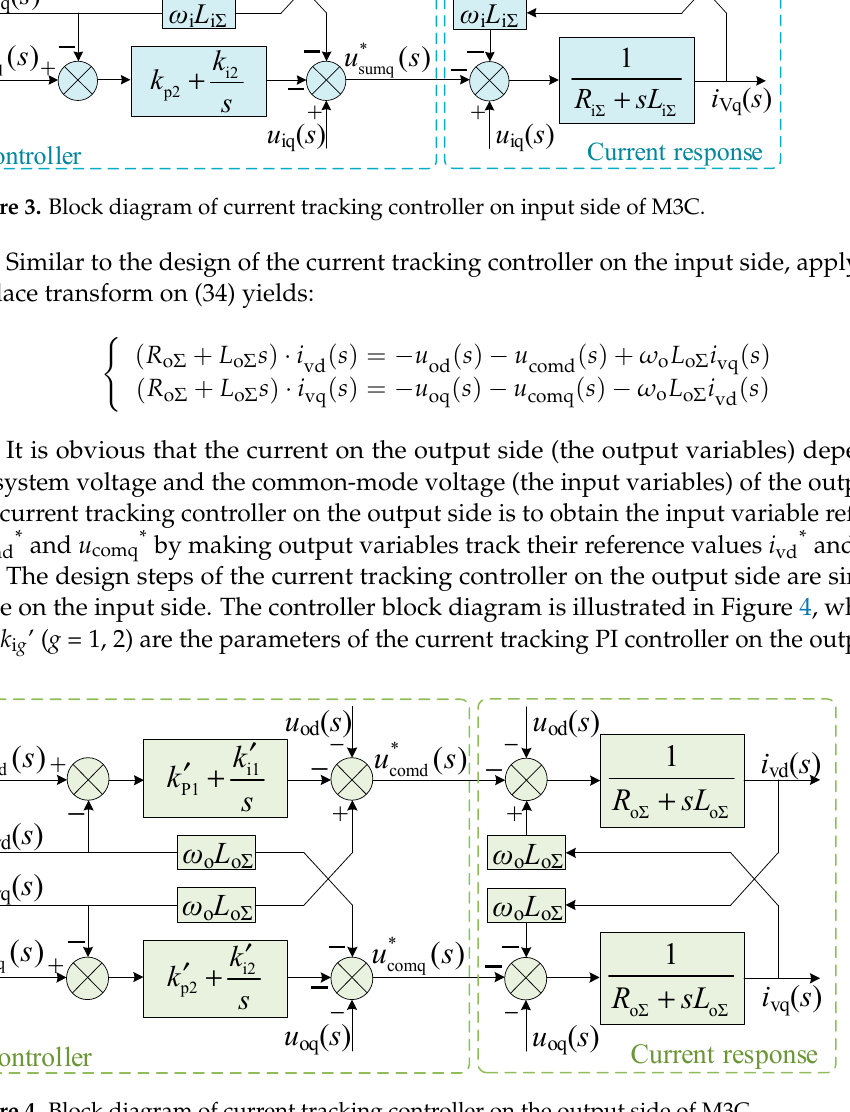
s Figure 2. d-axis and q-axis closed-loop control system of output current. In Figure 2, G C1 ( s ) and G C2 ( s ) are transfer functions of the d-axis controller and the q- axis controller, respectively: